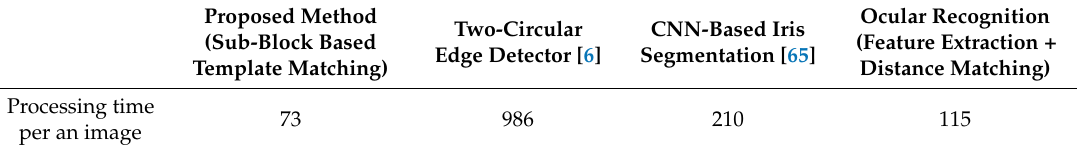
Table 14. Comparisons of processing speed by proposed method with other methods (unit: ms).